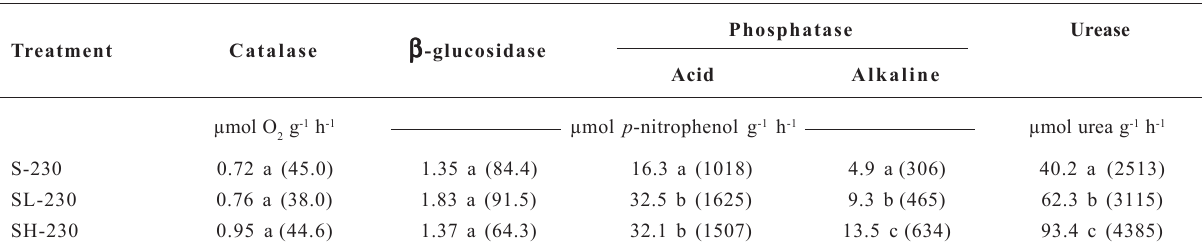
S: inorganic fertilizer-soil; SL: sewage sludge-treated soil (18 t ha -1 ); SH: sewage sludge-treated soil (36 t ha -1 ). Means not followed by the same letter in the column show significant differences (ANOVA and Tukey test, p <